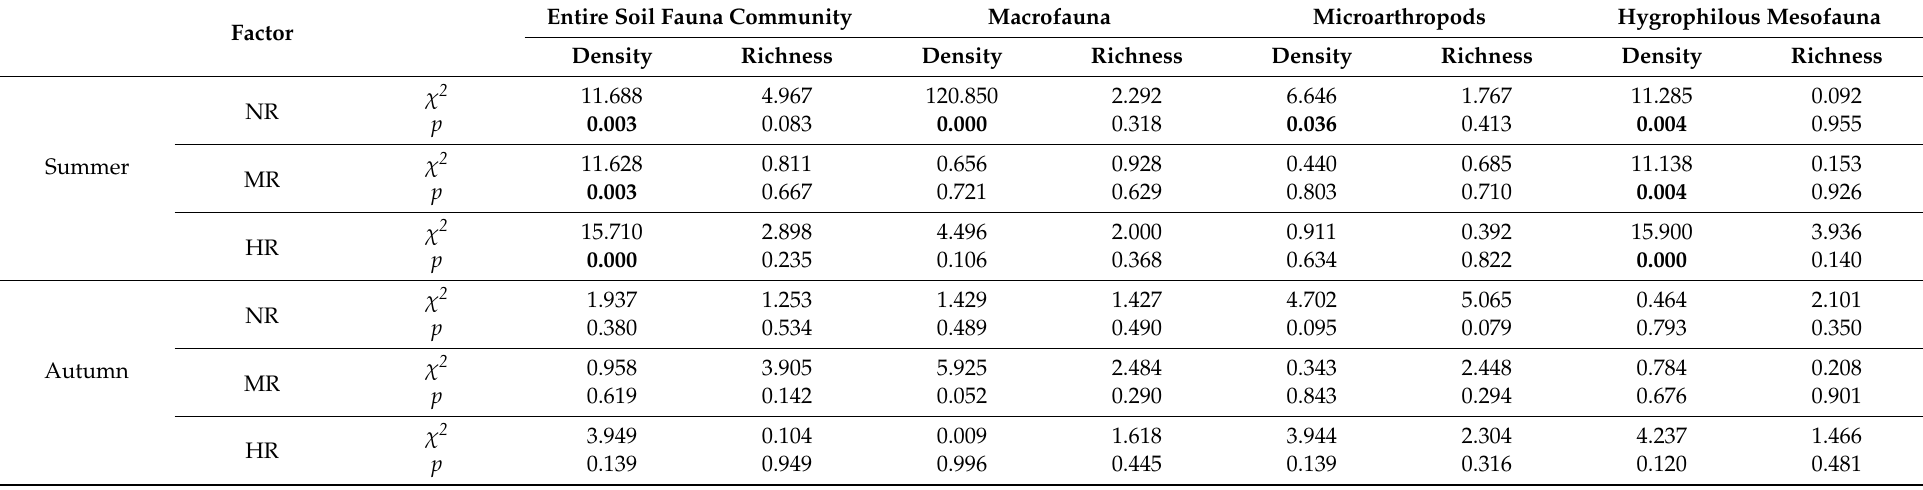
Table A4. Results of testing for the effects of distance gradient on soil fauna density and diversity in the same revetment type. χ 2 statistics for the likelihood ratio test and p values are